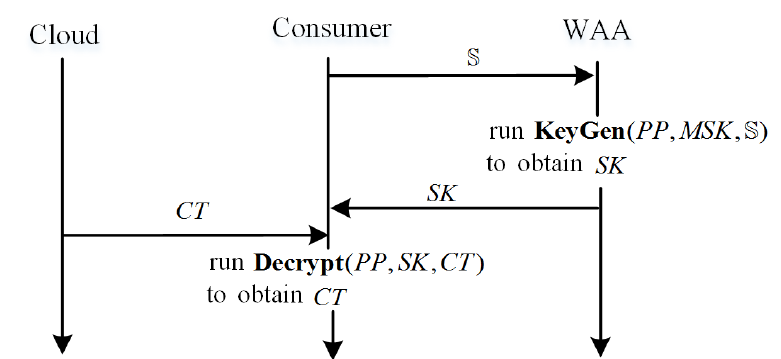
Figure 5. The process flow of